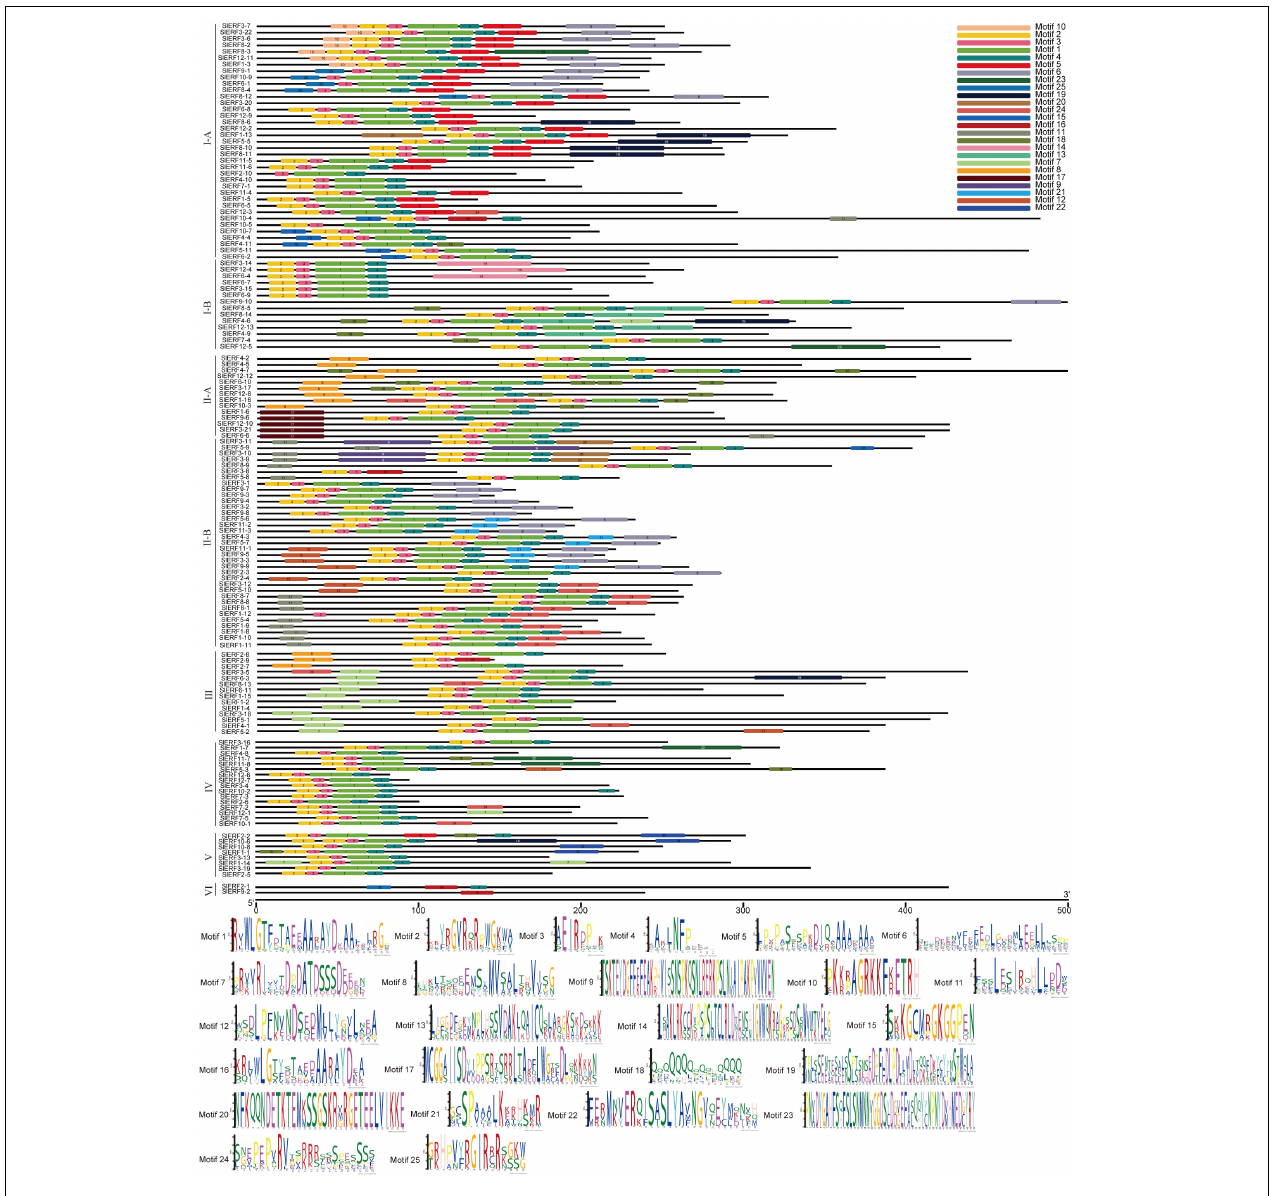
FIGURE 2 | Twenty-five motif predictive analysis of 60 DREB and 80 ERF proteins in tomato using a Multiple Em for Motif Elicitation